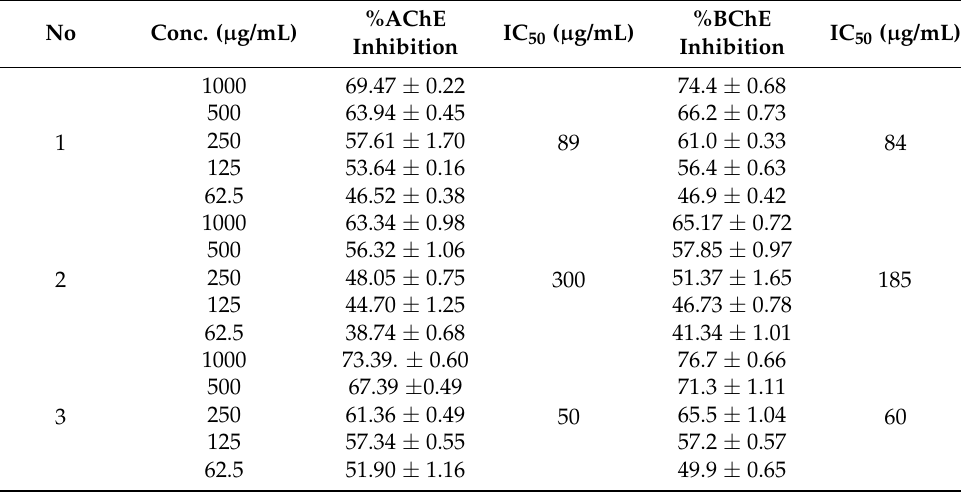
Table 4. Efficiency of compounds 1 – 6 as inhibitors against AChE and BChE.